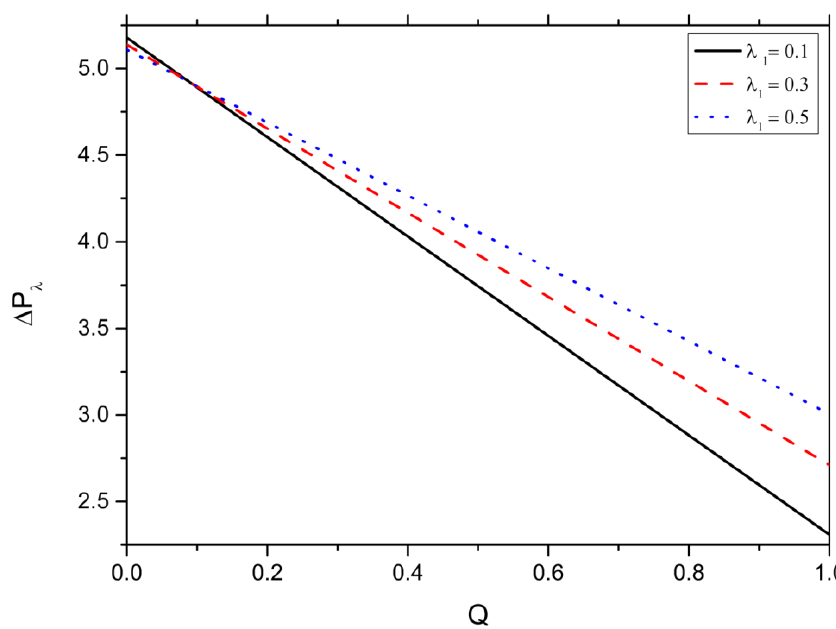
N = 0.3, N = 0.4,  = 0.01,  =0.1, Br = 0.3, Gr=0.5, b t   = , F = 0.1, z = 0.5. 6